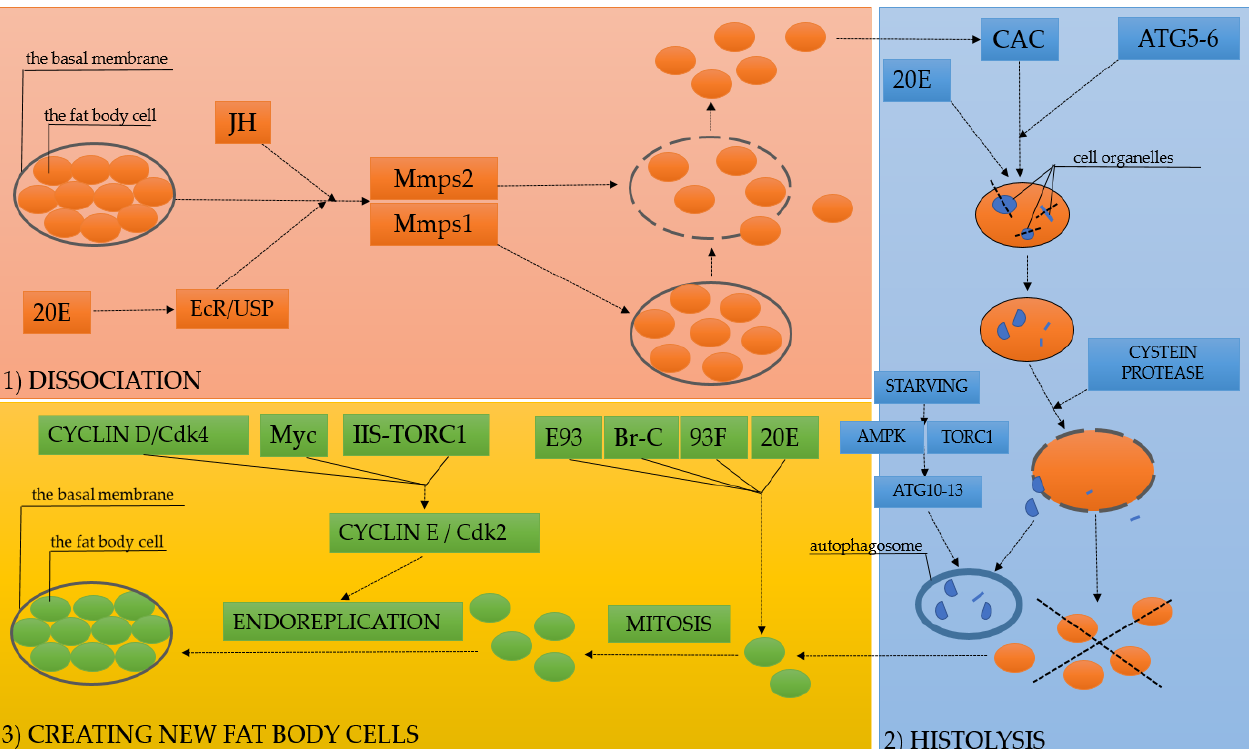
Scheme 1. The process of metamorphosis of the fat body of insects. JH—juvenile hormone; 20E—20-hydroxyecdysone; EcR/USP—ecdysone receptor/ultraspiracle protein; Mmps 1–2—metallo-proteinases; CAC—caspase activity cascade;